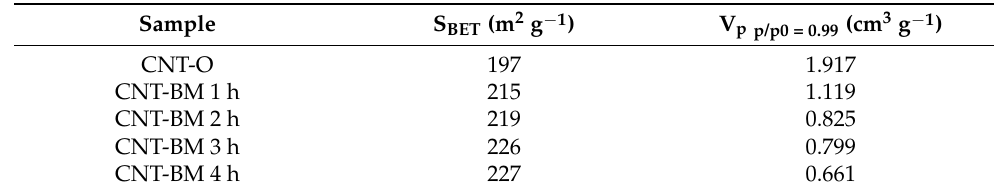
Table 1. Textural properties of pristine and modified